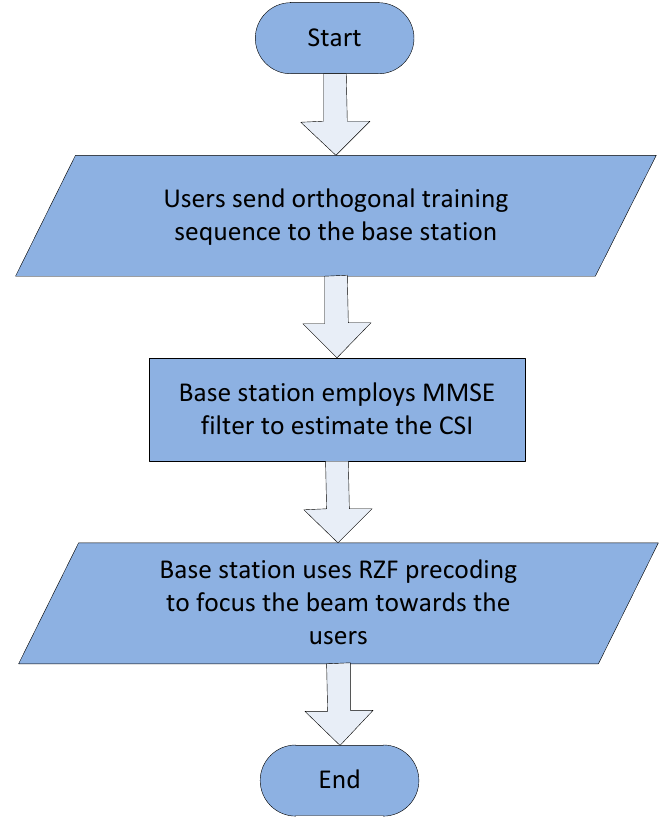
Figure 2. Flowchart of the transmission